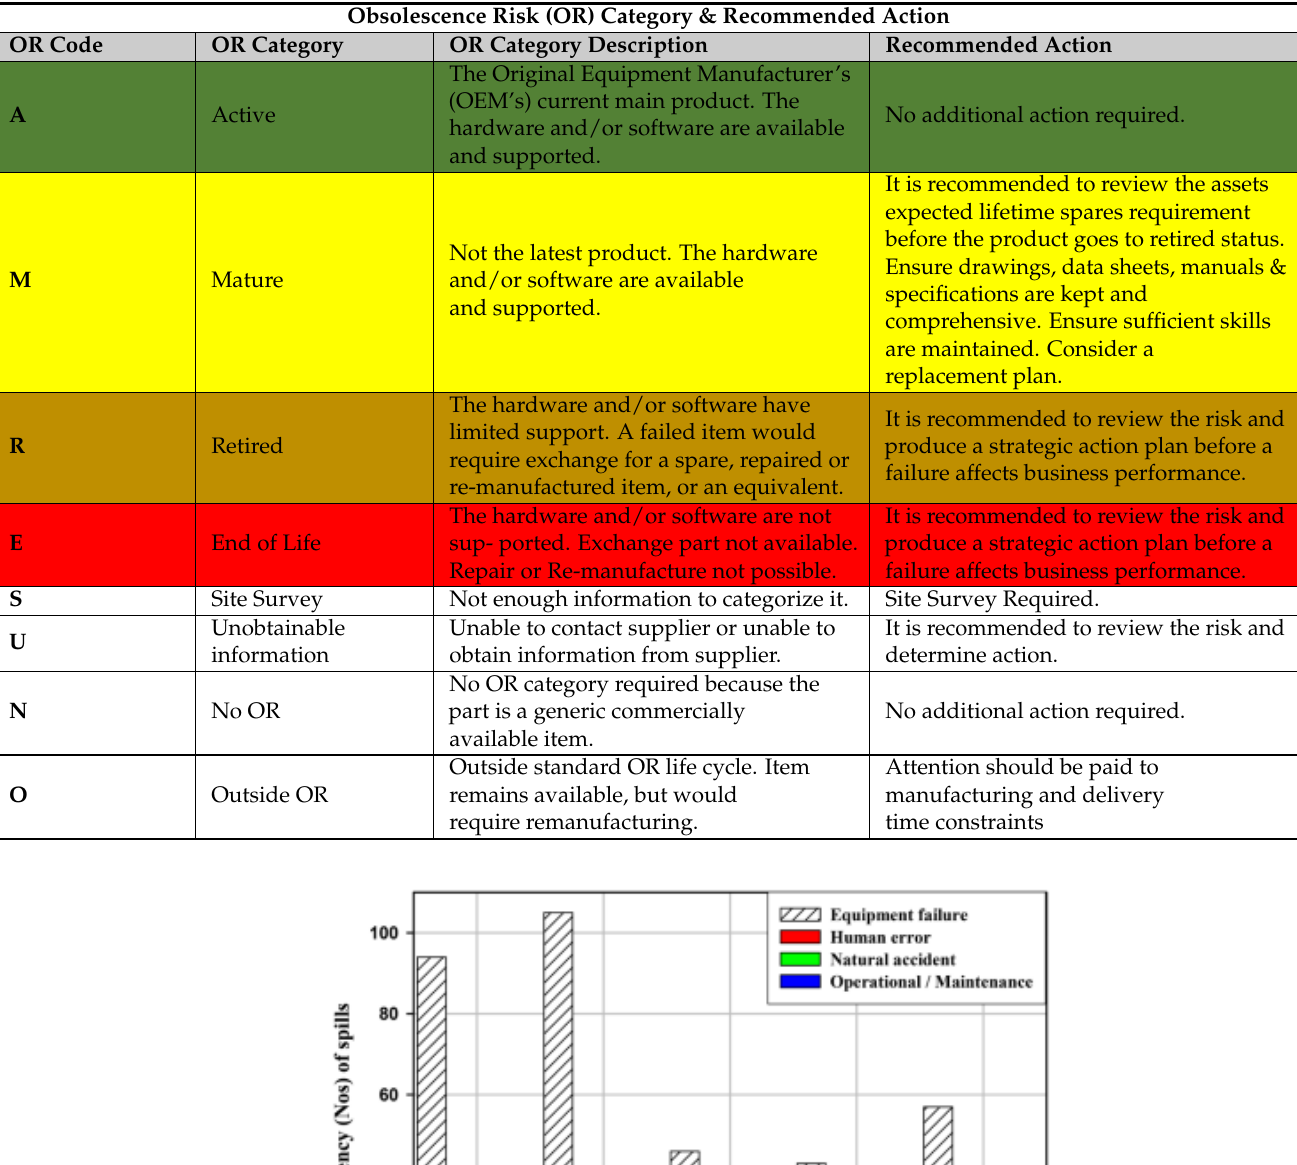
Table 3. Typical report for obsolescence risk (OR) category and recommended action. (Note: Green means active, Yellow means mature, Brown means retired and Red means end-of-life).